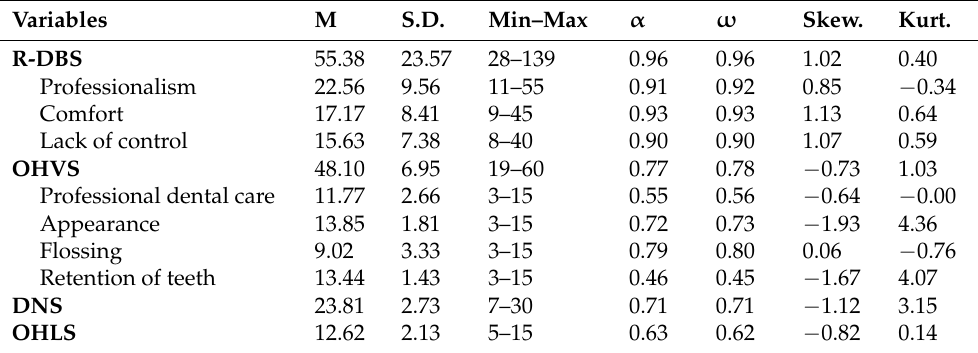
Table 2. The descriptive statistics of the variables involved in research (means, S.D., skewness, kurtosis, consistency coefficients).